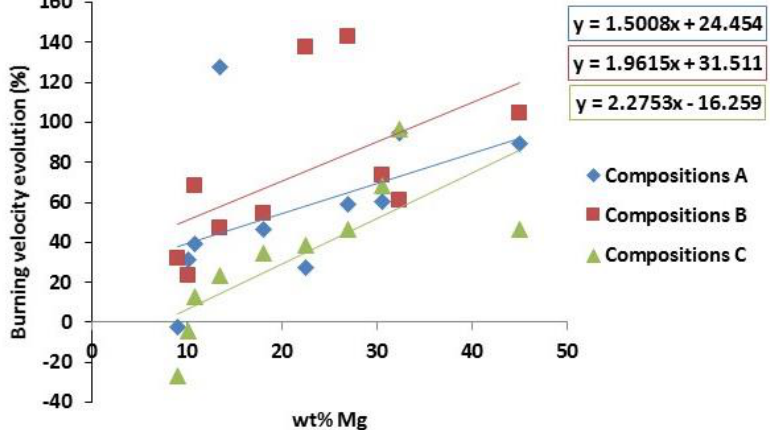
Figure 5. Quantification of burning velocity evolution of ternary compositions when reducing binder content from 10 wt.% to 5 wt.%. content from 10 wt.% to 5